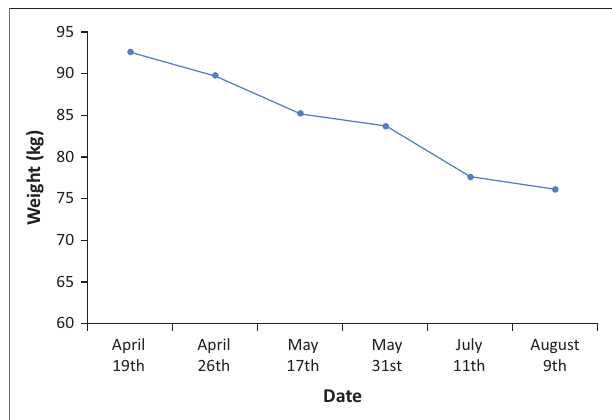
FIGURE 2: Change in body weight over the course of treatment.